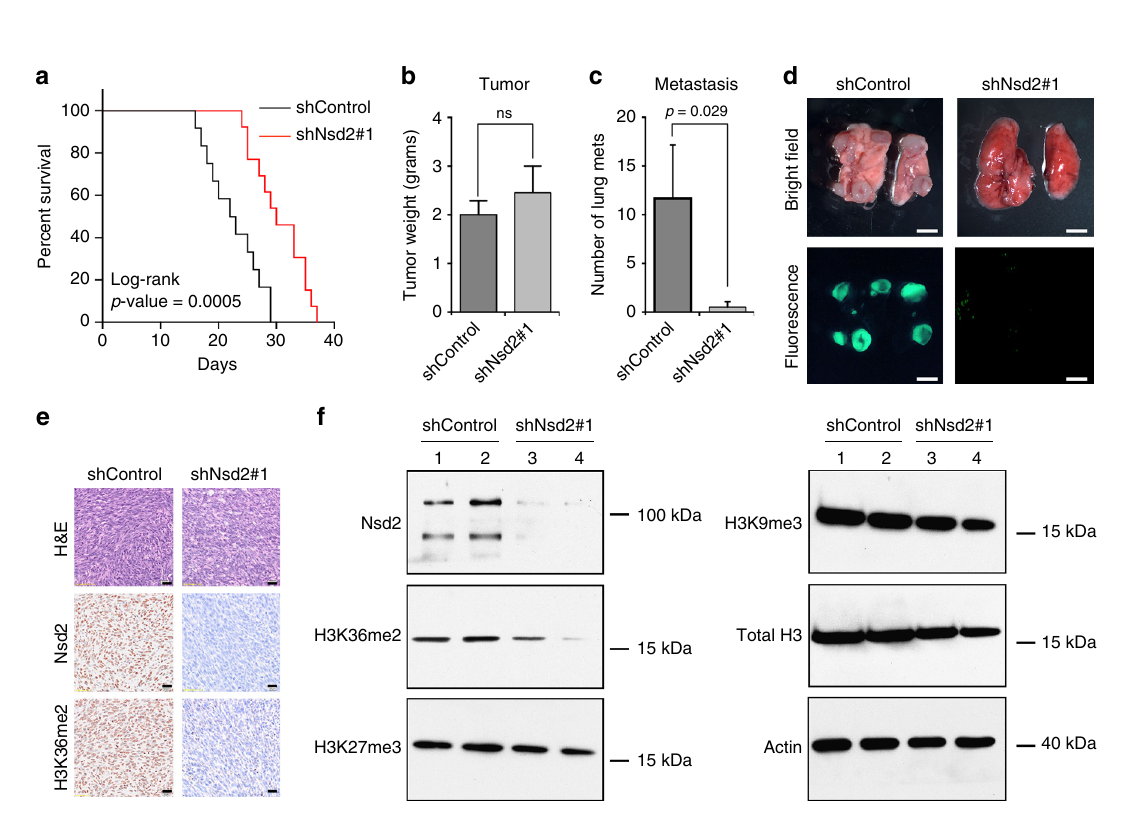
Fig. 6 Silencing of Nsd2 abrogates metastasis in vivo. Panels a – f show in vivo analyses of Nsd2 silencing in a mouse metastatic cell line ( NPK cells). Cells (1 × 10 6 cells) were engrafted subcutaneously into the fl ank of nude mice and the mice were monitored for up to 40 days. Studies were done using 2 independent shRNA for Nsd2; representative data for shRNA#1 is shown. a Survival analyses with the endpoint being tumor volume of 1.5 cm 3 ( n = 10/ group). The p -value was calculated using a log-rank test. b Analyses of tumor weights (in grams) at the time of killing (total n = 9/group). c Number of lung metastases per mouse (total n = 9/group). b , c p- values were calculated using the Mann – Whitney U test; error bars represent the standard deviation (s.d.) from the mean. d Representative whole mount and epi fl uorescence images of lung metastases. Scale bar represent 100 microns. e Representative immunostaining of shControl and sh Nsd2 tumors using the indicated antibodies ( n = 4/group). Scale bars represent 50 μ . f Western blot analysis showing representative cases from the shControl (lanes 1, 2) and sh Nsd2 (lanes 3, 4) tumors using the indicated antibodies (total n = 4/group). The position of a molecular marker is shown; uncropped images are provided in Supplementary Figure 5